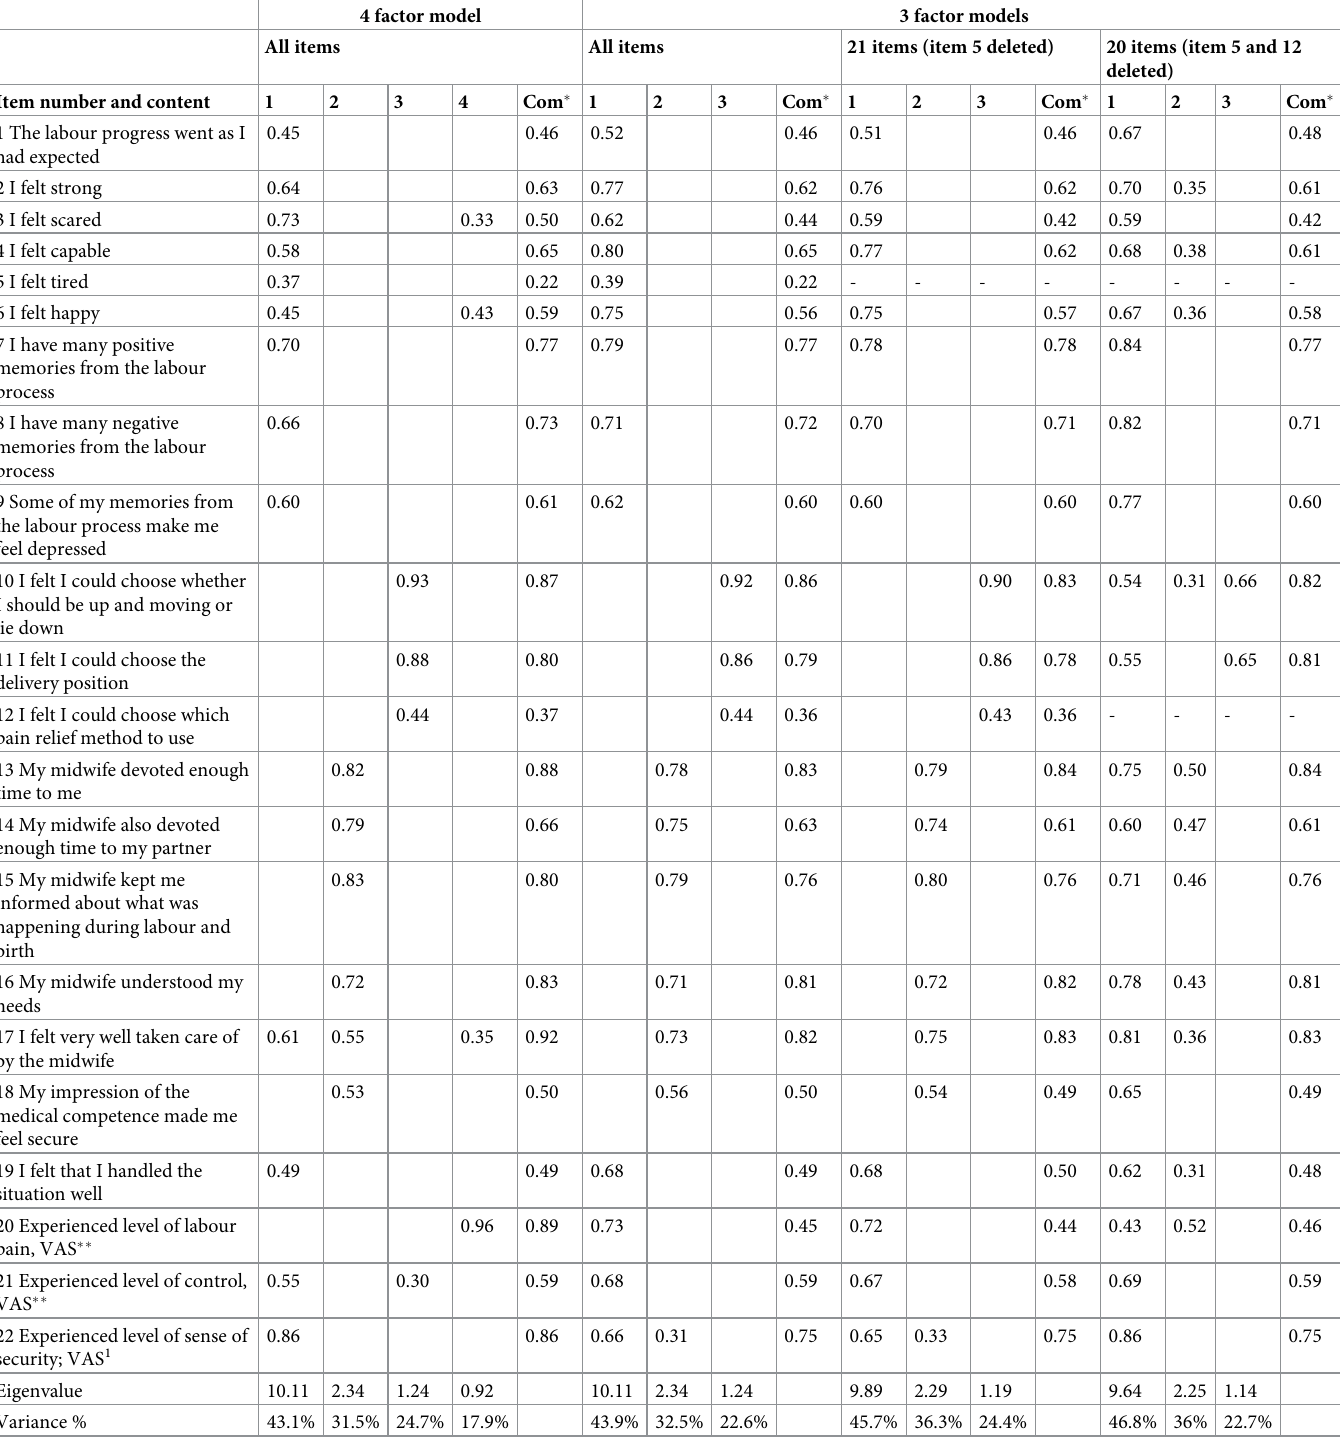
Table 4. Factor loadings, communality, eigenvalues, explained variance, and Cronbach’s a of 3 and 4-solutions after exploratory factor analysis with rotation. 4 factor model All